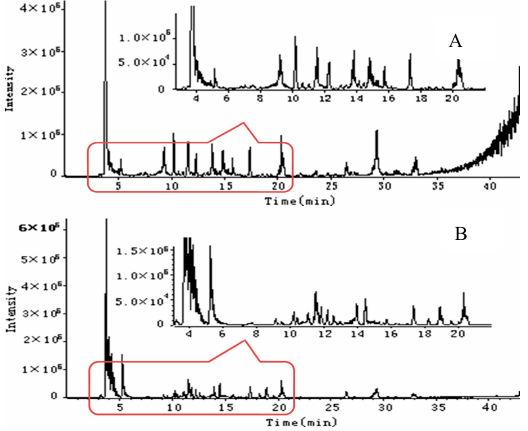
Figure 3. The representative total ion chromatograms of R. roxburghii ( A ) and R. sterilis ( B ) fruits obtained from UFLC/Q-TOF-MS in negative ion mode.